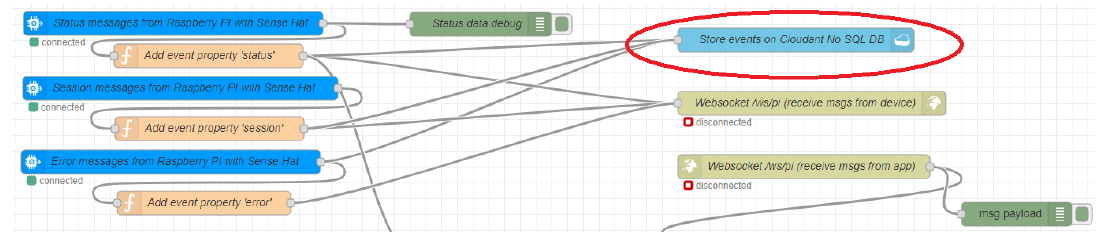
Figure 10. Cloudant integration in a Node-Red